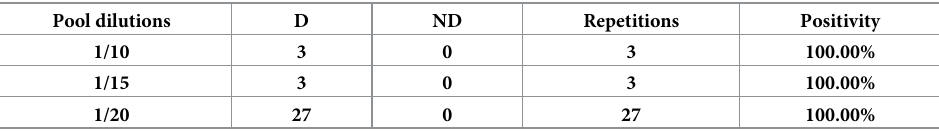
Table 5. Maximum grouping determination for saliva samples.